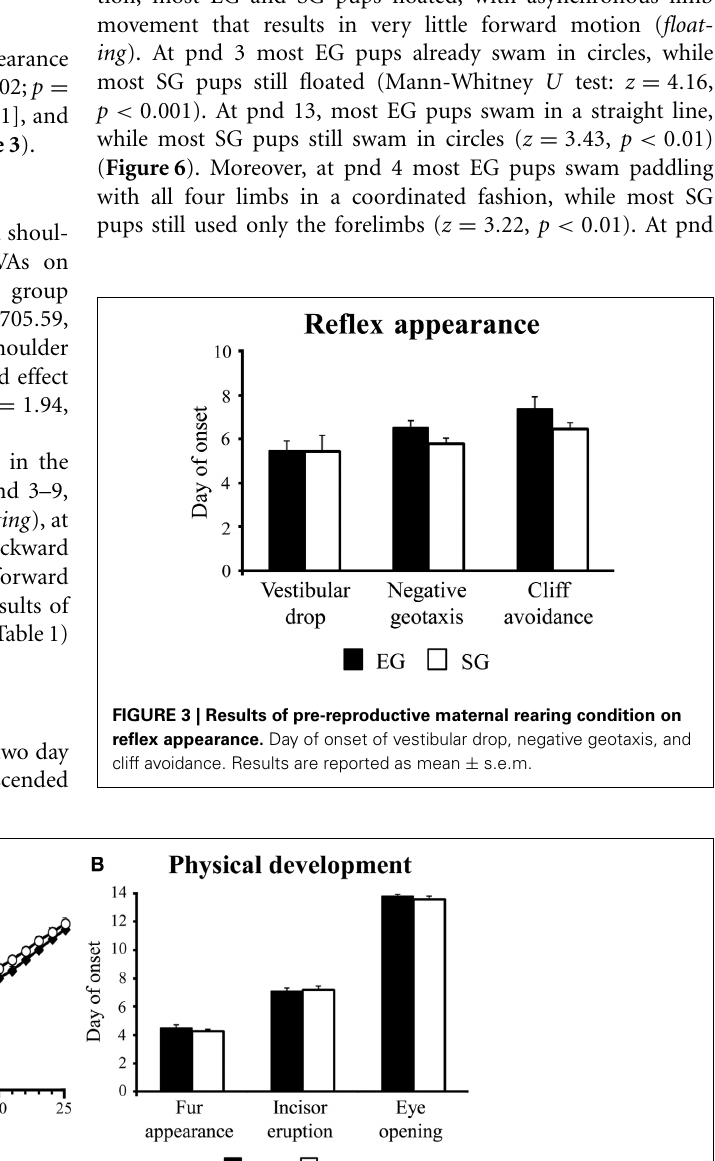
Frontiers in Behavioral